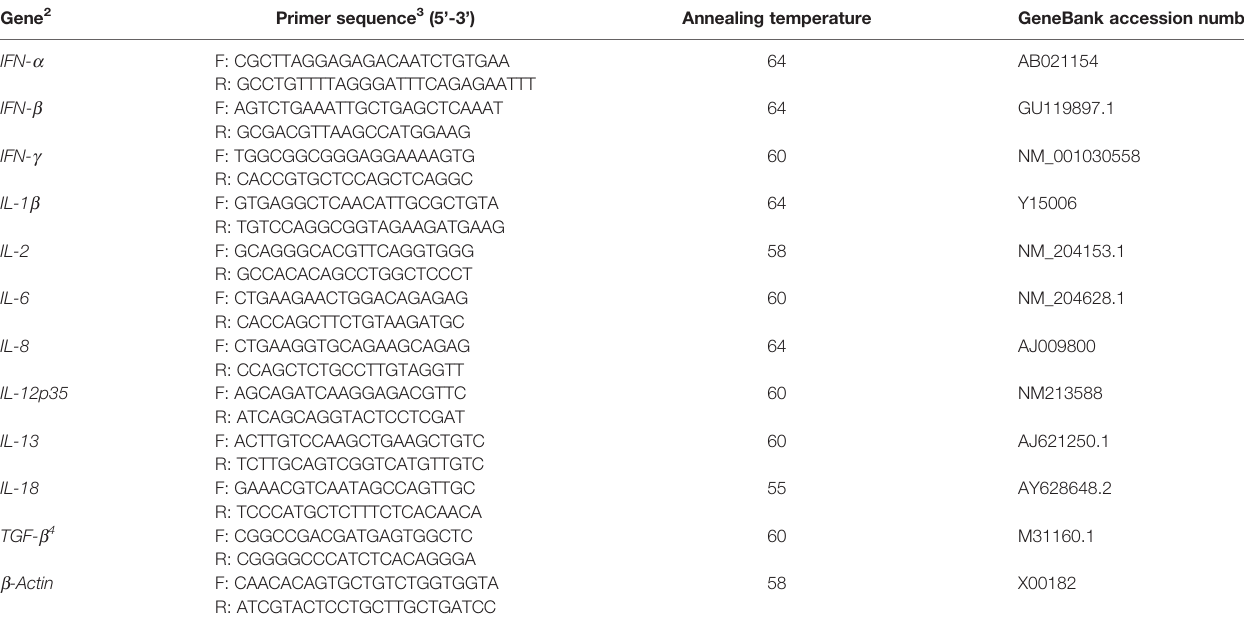
TABLE 2 | Primer sequences used for real-time quantitative PCR 1